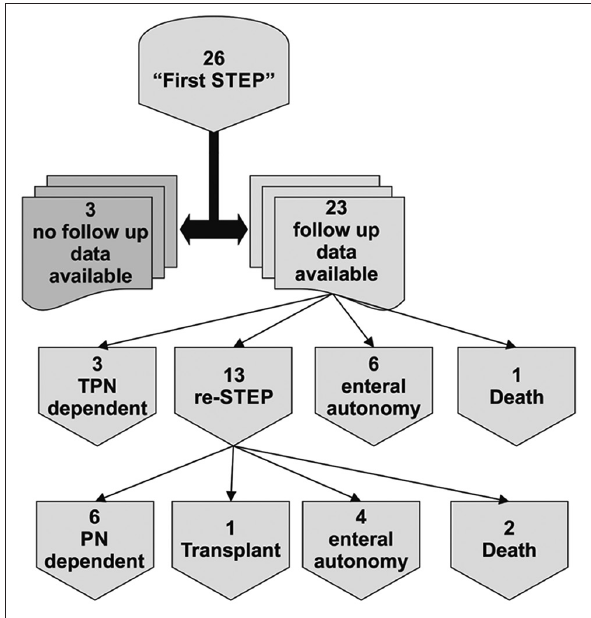
Figure 4: Outcomes of “First